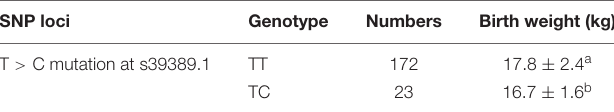
TABLE 3 | Association analysis between SNPs and weaning weight of Hu sheep. SNP loci